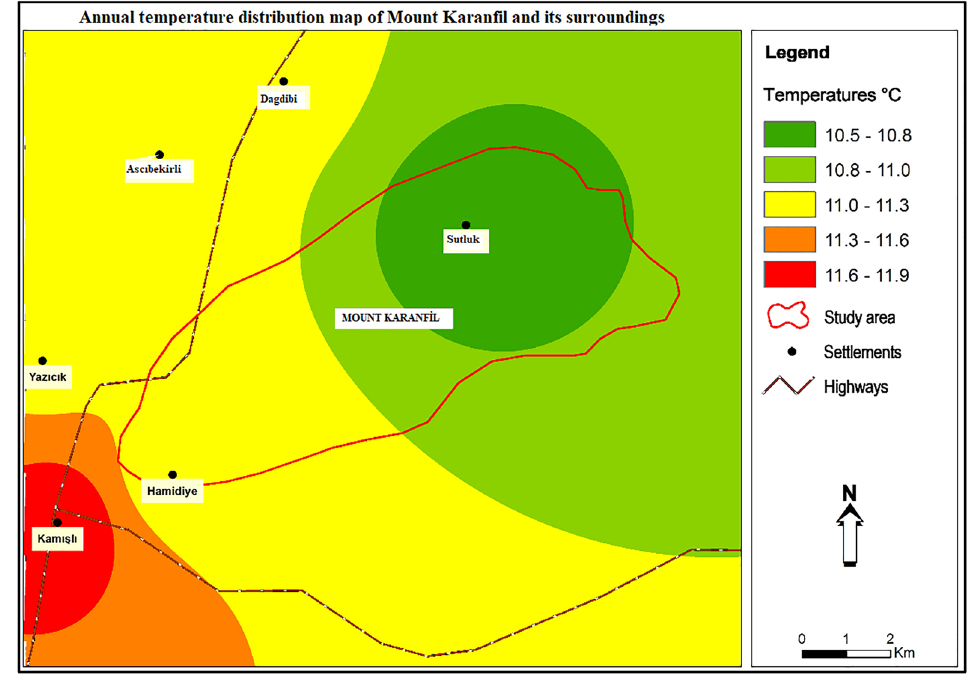
Fig. 4 Annual temperature distribution map of Mount Karanfil and its